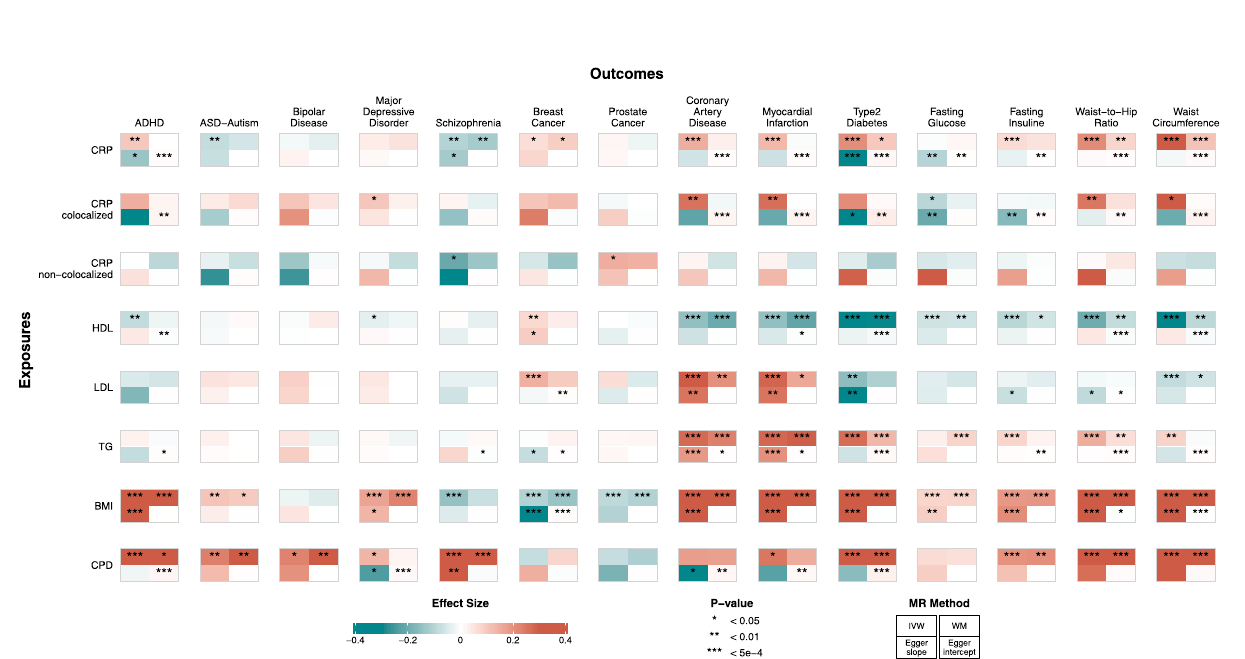
Fig. 5 | Two-sample Mendelian randomization results. Each row is a different exposure and each column is a different outcome. Each Mendelian randomization analysisissummarized inafour-squared boxincludingtheestimatesfrominverse- varianceweightedmethod(IVW,topleftsquare),weightedMedian(WM,topright), Egger method (slope, bottom left; intercept, bottom right). The color of each